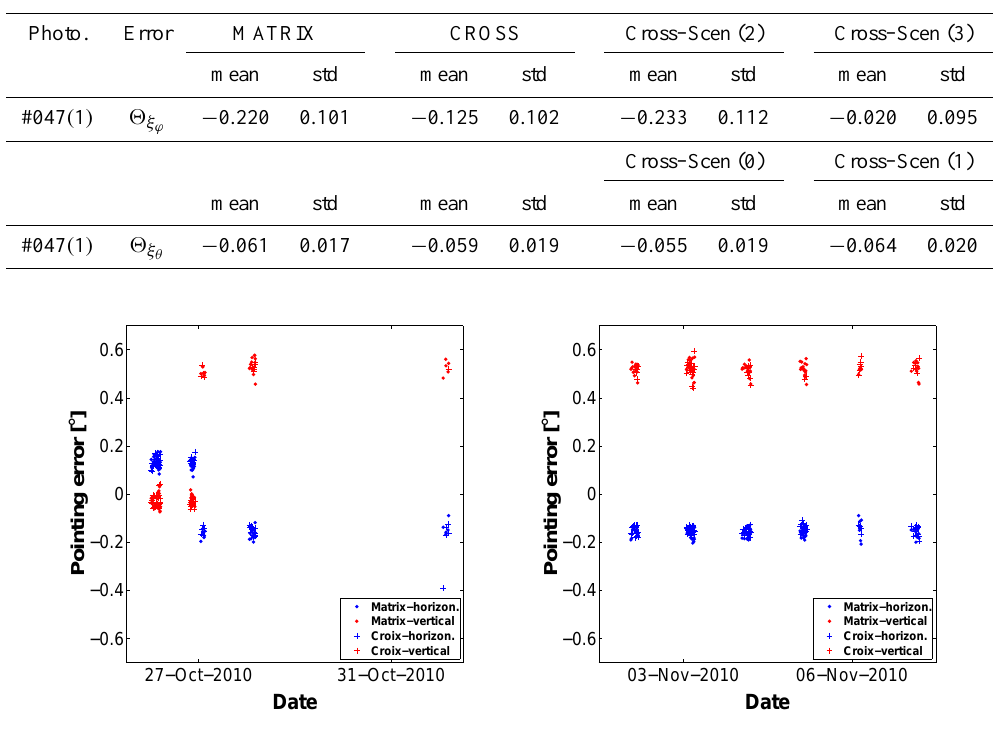
Fig. 10. Estimated center for matrix and cross measurements during the tests with the tracking system of sun-photometer #420 . Table 5. Pointing error statistics for the 7 analayzed photometers in the azimuth (Az) and zenith (Zn) directions. The data are provided for the two physical channels, visible and infrared, in order to check also the parallelism between them. Photo.